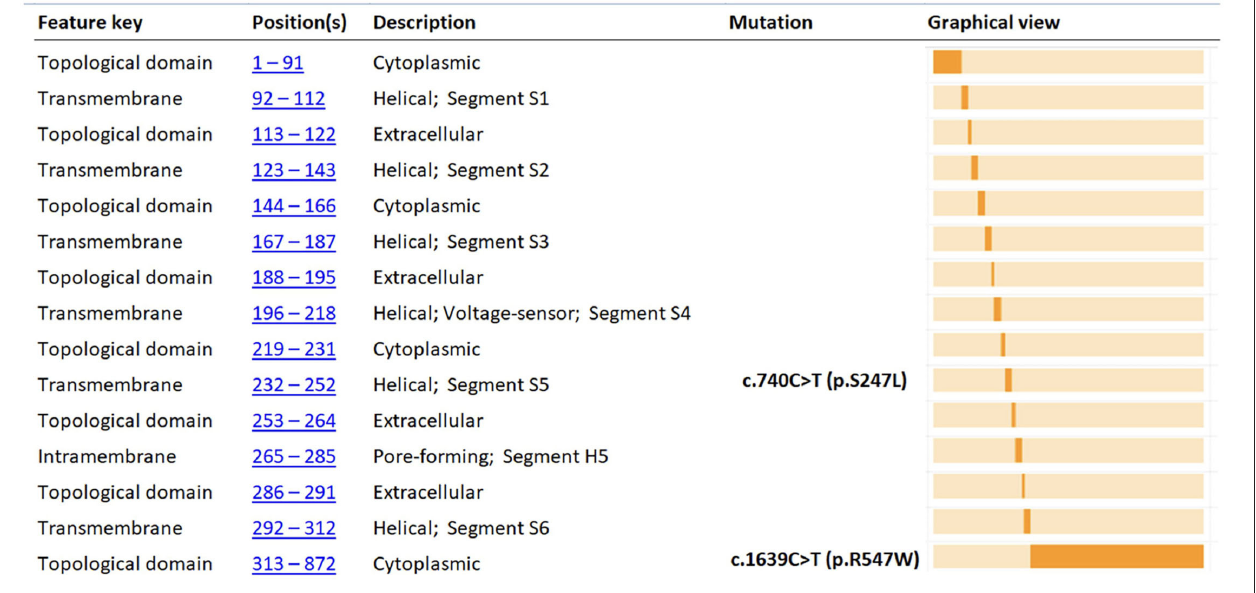
FIGURE 1 | Functional domain position of p.R547W and p.S247L amino acid changes of KCNQ2 protein (adapted from https://www.uniprot.org). The figure shows the KCNQ2 functional domain position of the variants found in our two cases (p.R547W and p.S247L). In silico analysis ( Table 2 ) predicted that the two mutations have potential strong damaging effect on the structure/function of the KCNQ2 protein.